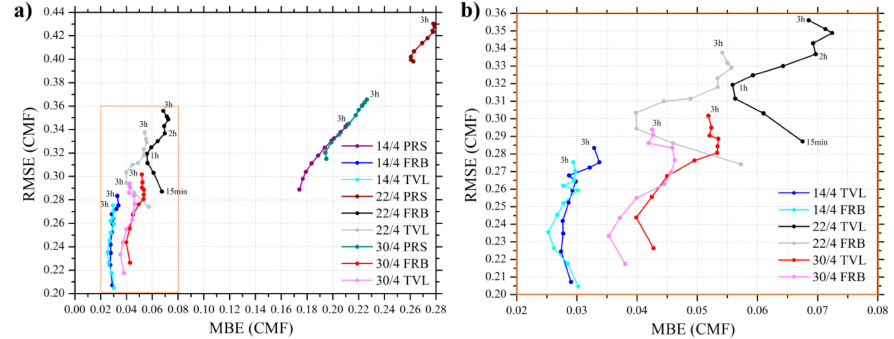
Figure 7. The CMF error during the 3 case study days for the PRS, FRB and TVL short-term forecasting approaches as a function of RMSE and MBE ( a ), and a zoomed plot for the two CMV methods ( b ) as to highlight the similarities and discrepancies of the same